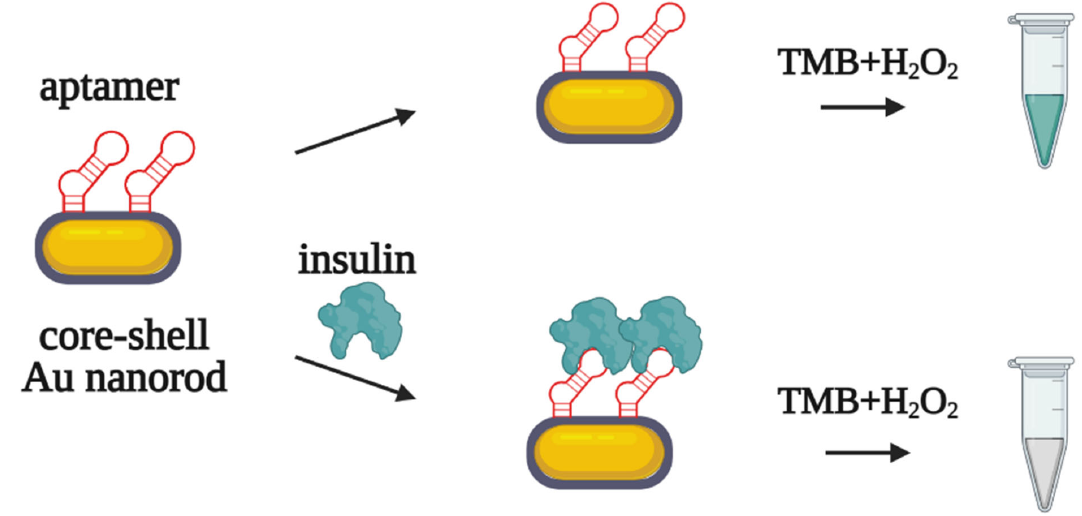
Figure 10. Insulin detection by aptasensor based on Au nanorods with peroxidase-like activity [59]. Without insulin, AuNRs catalyze the oxidation of the chromogenic substrate (TMB) in a peroxidase- like manner, resulting in a color change in the solution. Insulin binds with the aptamer on the AuNRs and inhibits the oxidation of TMB.